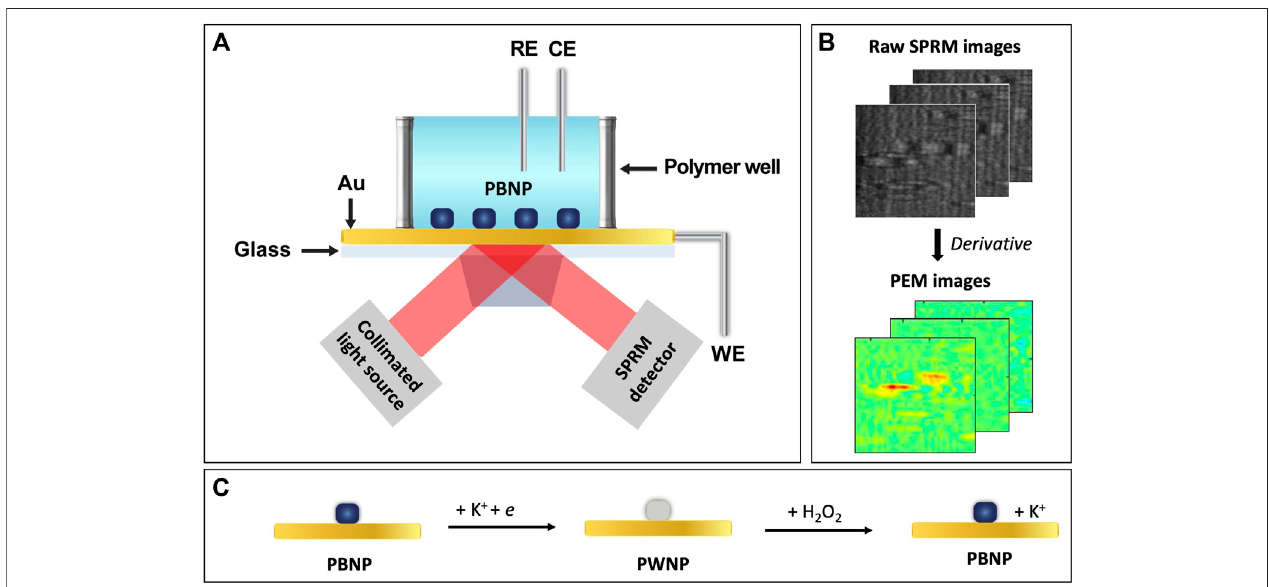
FIGURE 1 | Schematic of (A) the PEM experimental setup, (B) image processing, and (C) the redox reaction at a